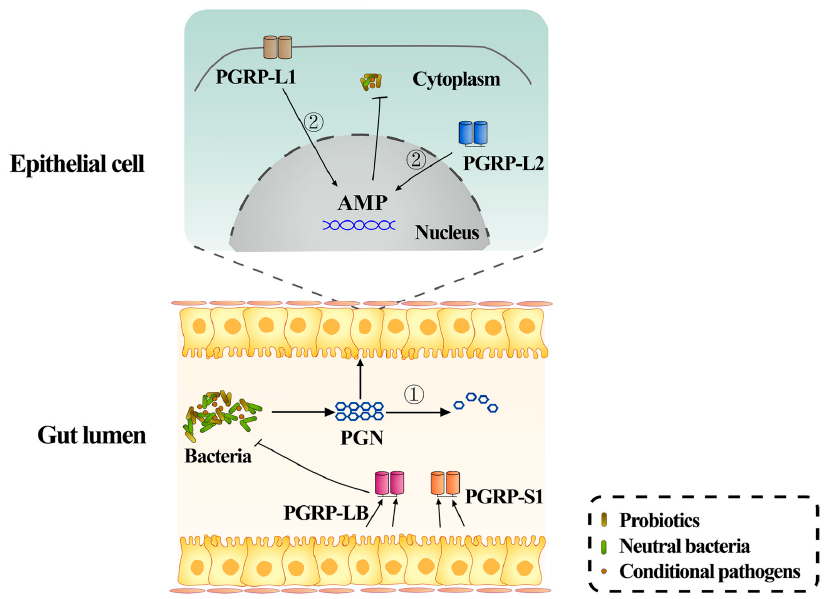
Figure 2. The role of RPW gut immunity in the regulation of intestinal bacterial homeostasis. Several PGRPs in RPW have been confirmed to be involved in the regulation of gut bacterial homeostasis via the different ways [61,65–67]. PGN: Peptidoglycan. AMP: Antimicrobial peptides. ① : Peptidoglycan degradation. ② : The activation of AMP synthesis.